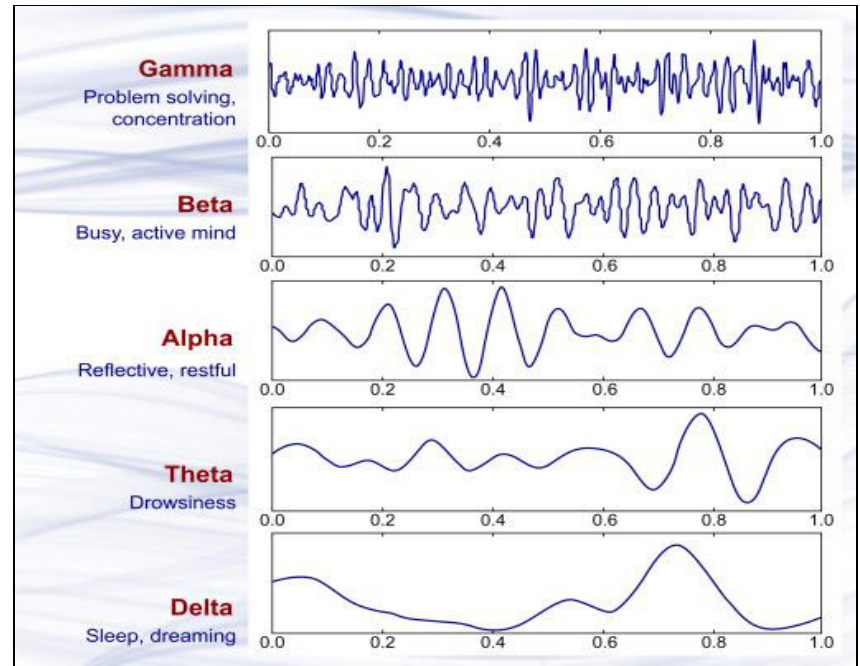
Figure 1. Brain wave samples with dominant frequencies belonging to beta, alpha, theta, and delta bands and gamma waves [84]. “Reprinted from Introduction to EEG- and Speech-Based Emotion Recognition Priyanka A. Abhang Bharti W. Gawali, Suresh C. Mehrotra, Chapter 2–Technological Basics of EEG Recording and Operation of Apparatus, Pages No- 19–50, Copyright (2016), with permission from